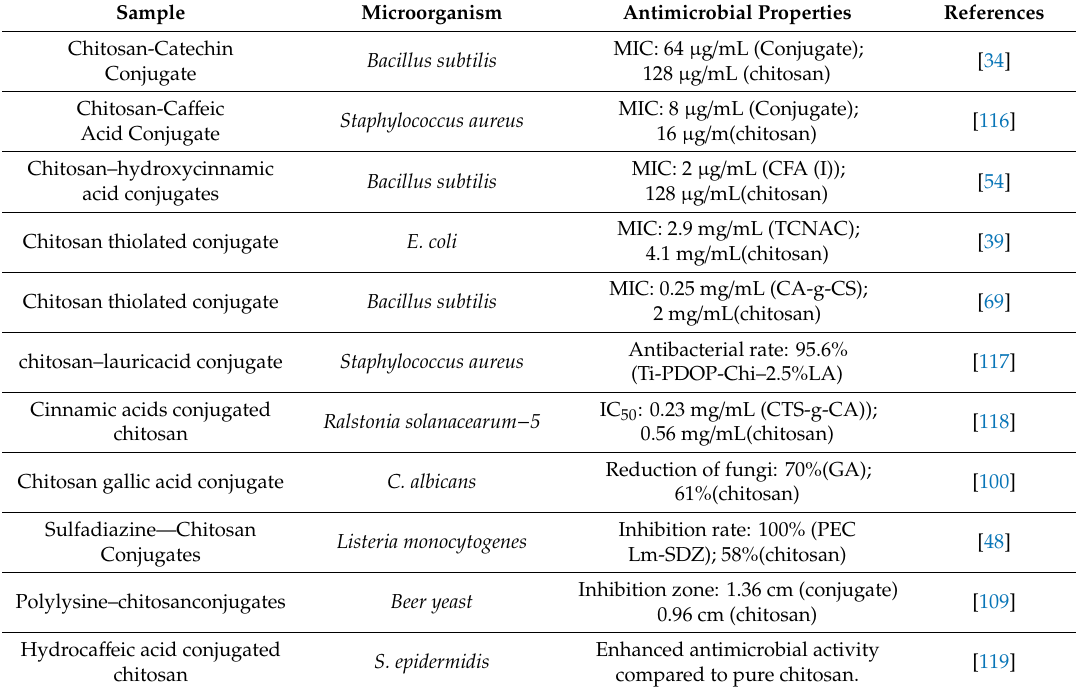
Table 2. Antimicrobial activities of representative chitosan